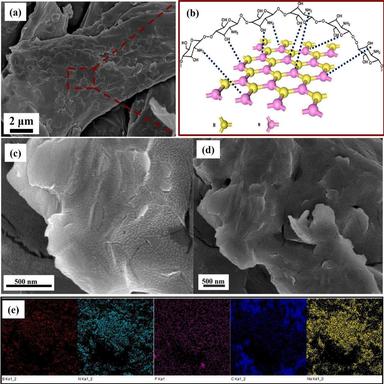
The SEM images of (a) the BNCA wall; (b) the interaction between h-BN and CA; (c–e) micro-structure and elemental analysis of BNCA/SDG composite PCMs.